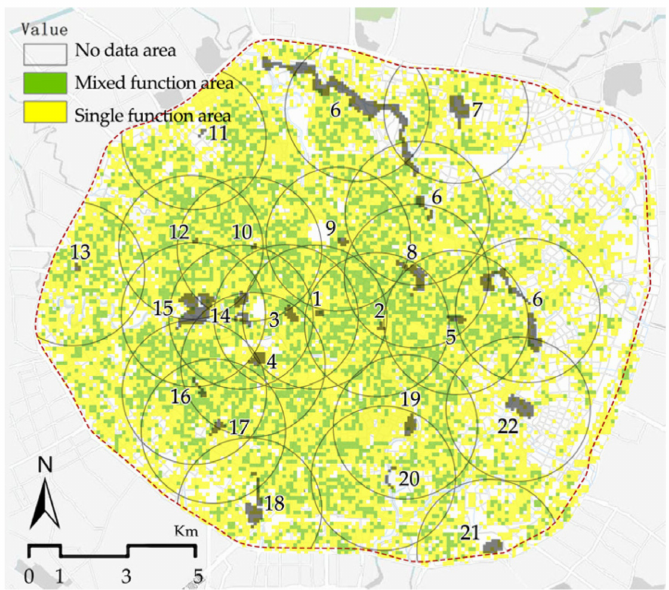
Figure 6. Spatial heterogeneity of the function mixing